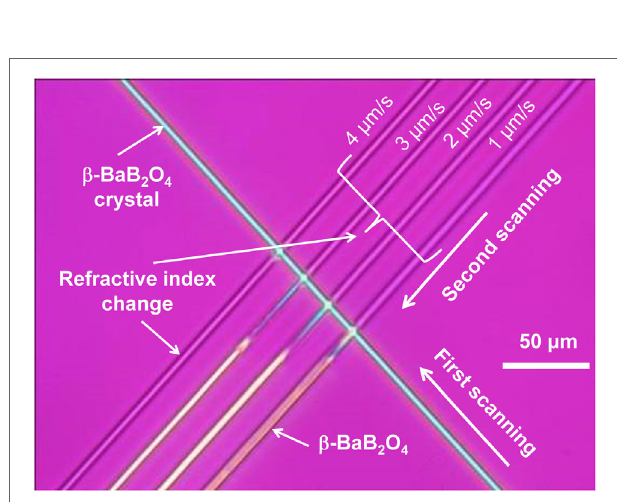
FigUre 3 | schematic experimental procedure for the patterning of crossing crystal lines . First, the crystal line ① was patterned, and then, the second laser irradiations ② were carried out for the first line with the crossing angle of